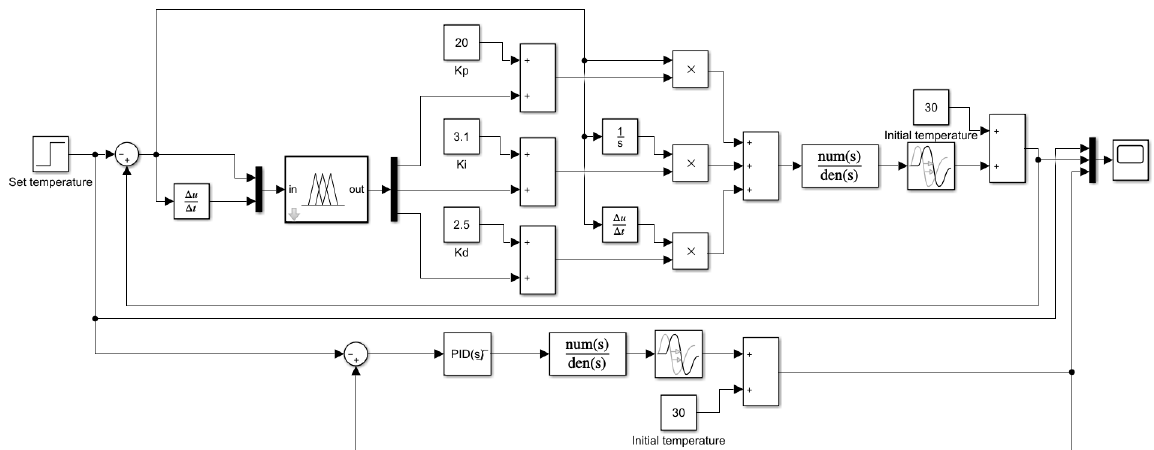
Figure 12. MATLAB/Simulink system simulation. Figure 13. Simulation comparison of control effects. Table 1. Table of the fuzzy control rules ( ∆𝐾 𝑝 / ∆𝐾 𝑖 / ∆𝐾 𝑑 ).